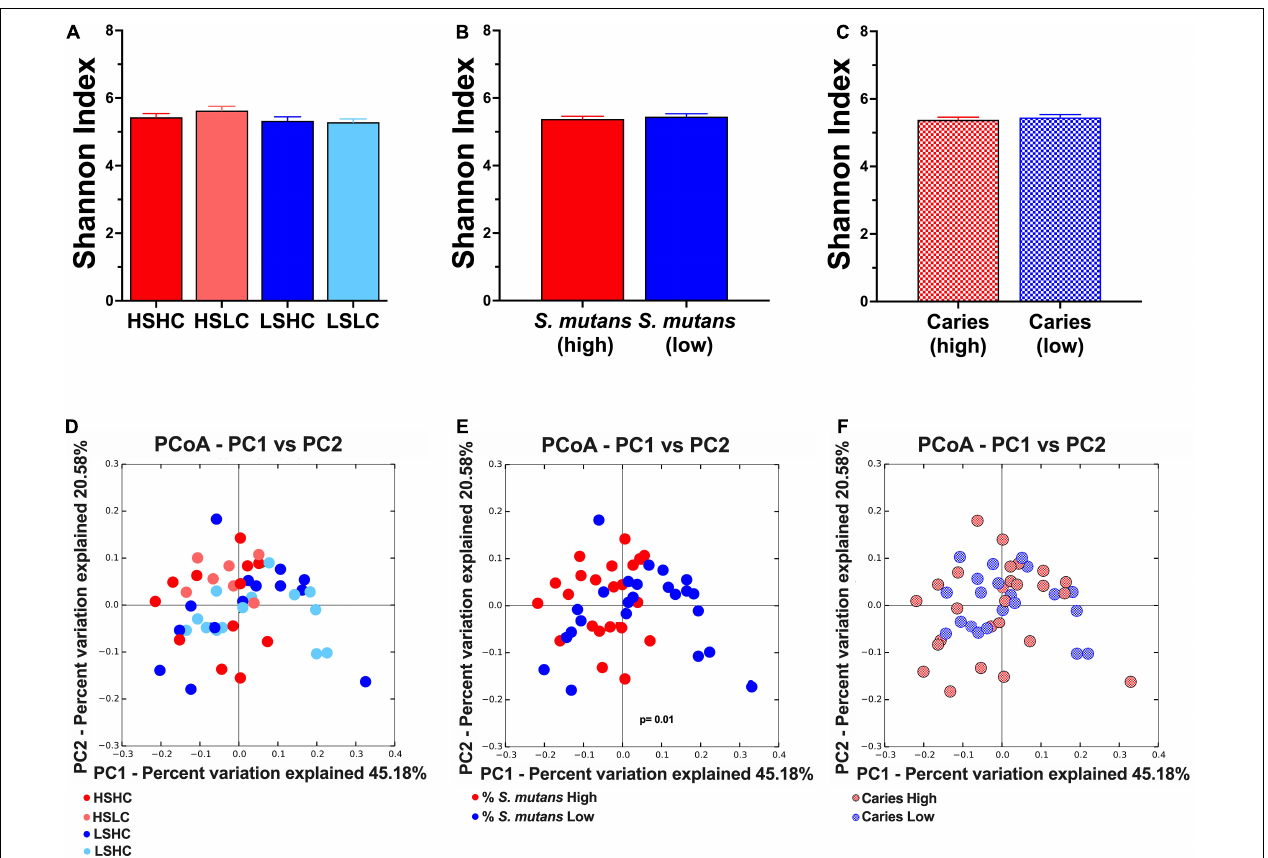
FIGURE 4 | Alpha- and Beta- diversity analyses of salivary microbial community. Alpha diversity was analyzed using Shannon index (upper panel, A–C ). The beta diversity was by principal coordinates analysis (PCoA) of weighted UniFrac distances (lower panel, D–F ). The analyses were performed based on the following parameters: (A,D) per group (HSHC, HSLC, LSHC, and LSLC); (B,E) S. mutans levels (High, Low); and (C,F) caries experience (High, Low). The graphic bars represent means, and error bars represent the standard deviation (SD). The differences in significance of the groups was performed by one-way ANOVA followed by Kruskal–Wallis multiple comparisons tests (alpha diversity) or ANOSIM (beta